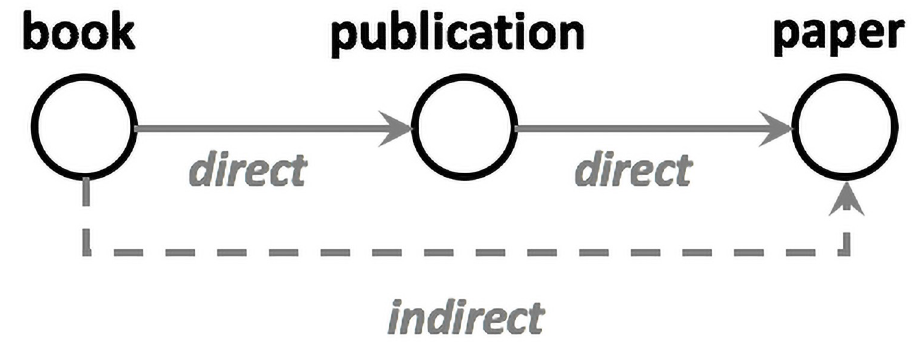
Fig 1. Illustration of the synonym relationship